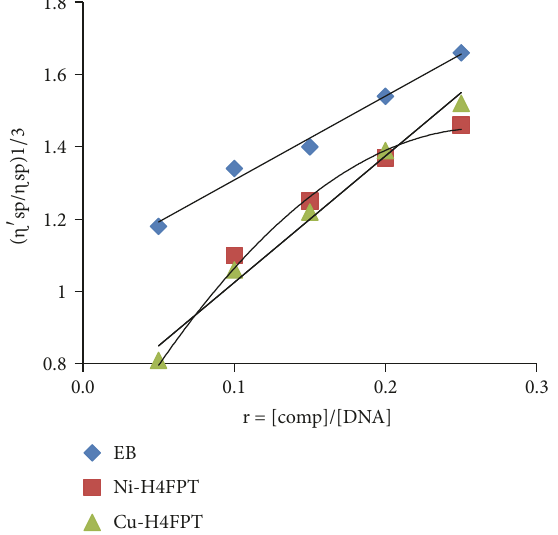
Figure 5: Effect of increasing amount of EB and Ni(II) and Cu(II) complexes on the relative viscosity of CT-DNA at 27.0 ∘